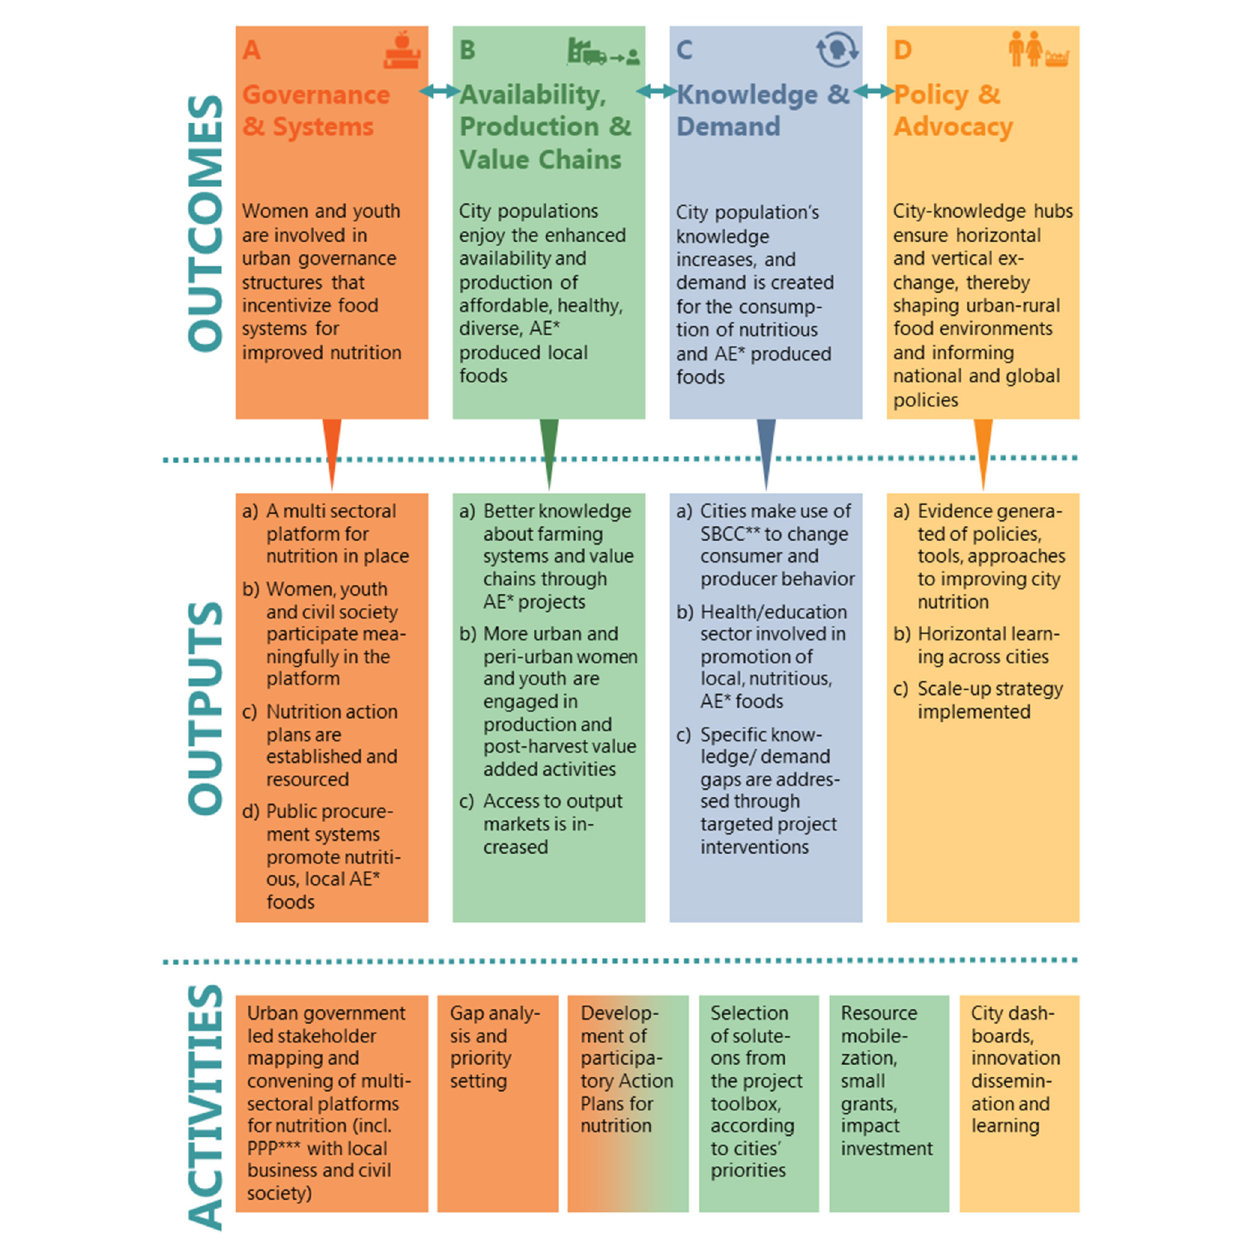
FIGURE1 Theory of change of NICE with respective outcomes, outputs and underlying activities. In order to achieve its objectives to improve the food and nutrition security of city populations and to reduce poverty by increasing the demand and supply of healthy, diverse diets consisting of nutritious and agroecologically produced food, the NICE project works toward four outcomes (A–D) resulting from 13 outputs and their respective required activities. *AE, agroecology/agroecological/agroecologically; **SBCC, social behavior change communication; ***PPP, public-private